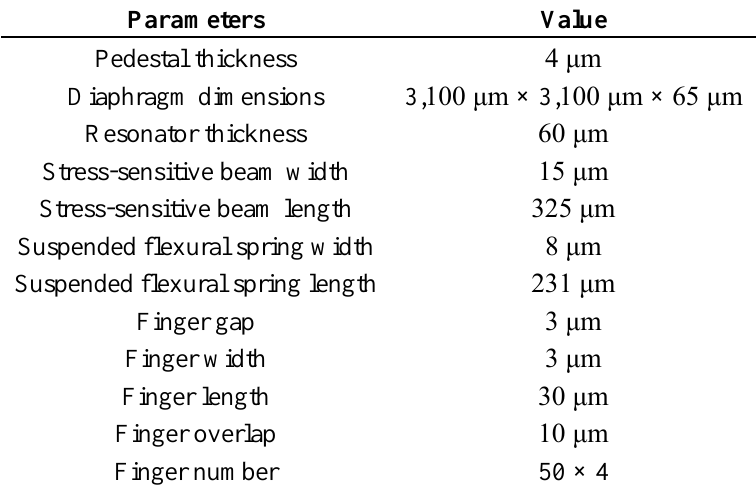
Table 1. Primary design parameters of the resonant pressure